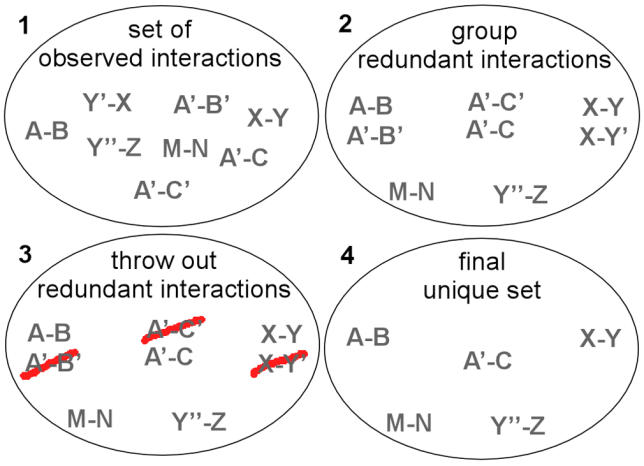
Creating Sequence-Unique PPI sets(1) Starting with a dataset of PPIs, we first cluster the data according to sequence similarity (apply a certain homology threshold) into sequence similar PPIs (2). Note here that the interactions A′-B′ and A′-C′ do not fall into the same cluster because B′ and C′ are unrelated. Thus, for two interactions (e.g., A-B and A′-B′) to be considered similar by our algorithm, both interacting proteins (A and B) have to be homologous to the two proteins of the other interaction (A has to be similar to A′ and B has to be similar to B′). (3) We randomly throw out all redundant interactions in each cluster so that only one PPI remains as a representative of each cluster. (4) Those representatives constitute the final unique dataset of PPIs.